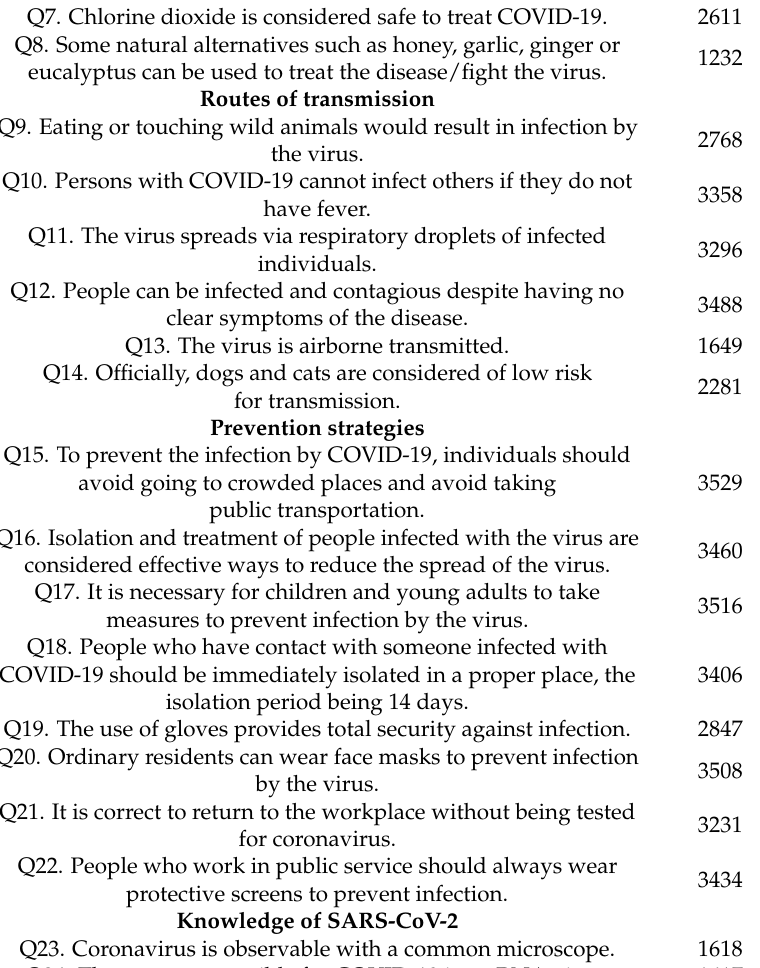
Not Incorrect Correct % % Answers Answers